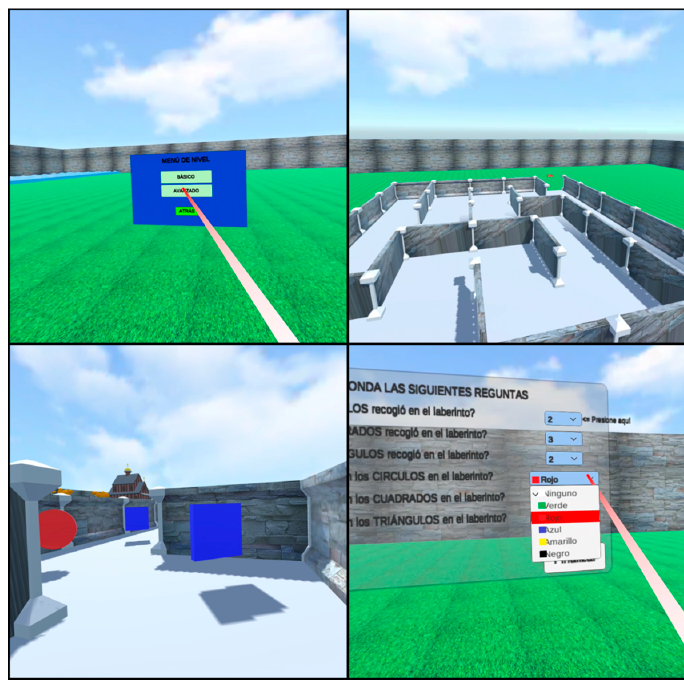
Figure 9. Immersive virtual reality scene views at the advanced level.